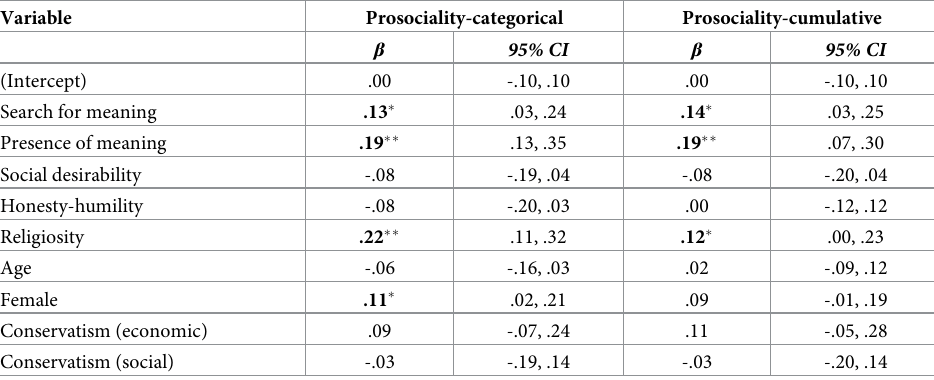
Table 11. Multiple regressions predicting costly prosociality with search for meaning in Study